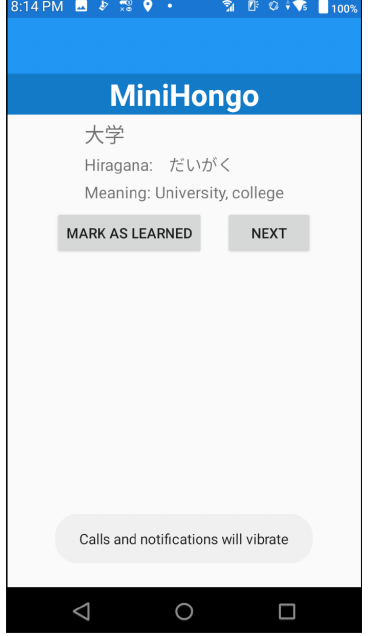
Figure 7. Lesson